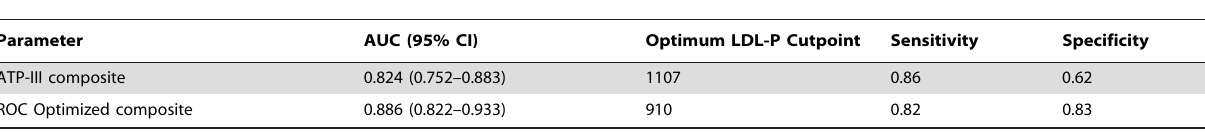
Table 4. Receiver operating characteristic curve analysis of LDL-P as a predictor of achieving composite LDL-C, non-HDL-C, and triglyceride composite targets, ATP-III very high risk (ATP-III Composite) or composite of univariate ROC optimized LDL-P cutpoints, nmol/L, for the same parameters (table A, ROC Optimized).